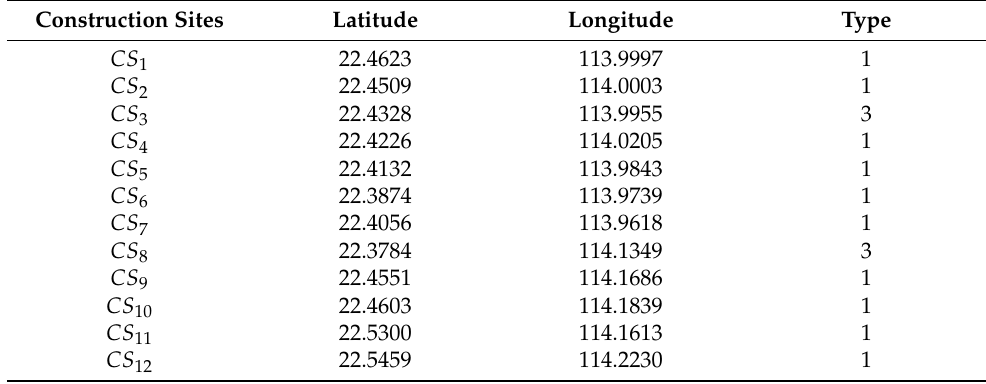
Table A2. List of all construction